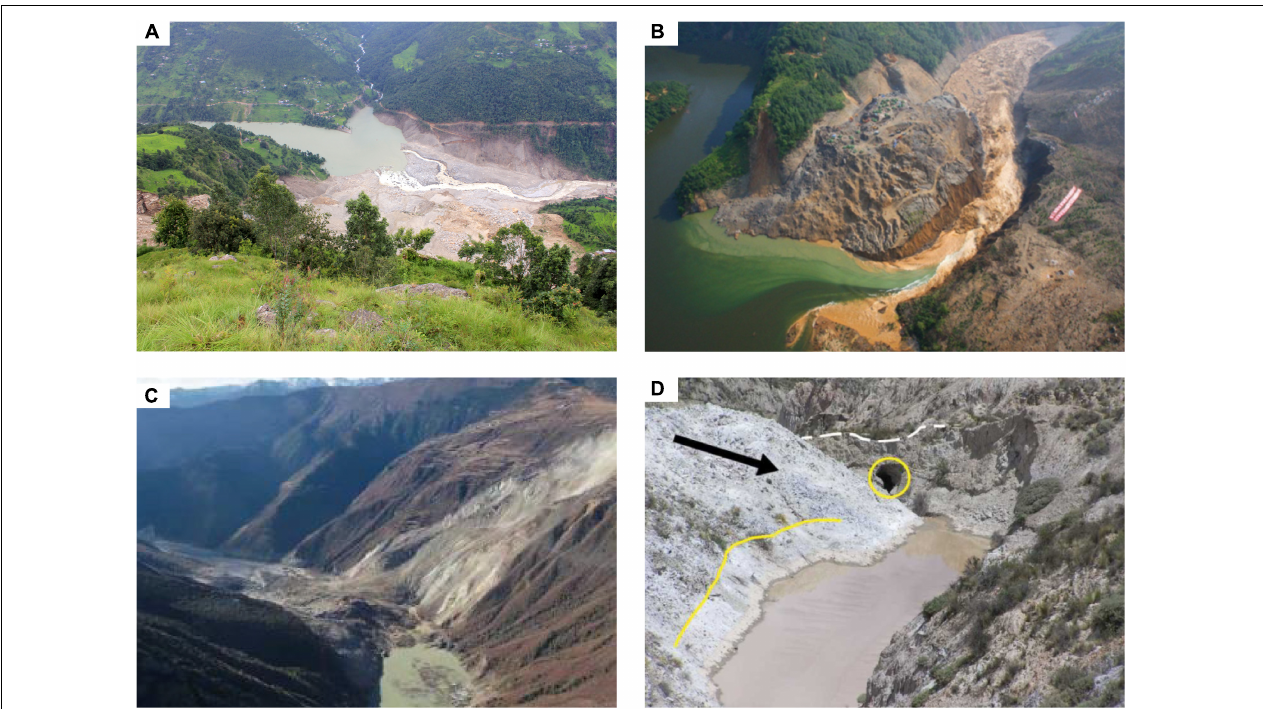
FIGURE 2 | Landslide dam cases. (A) Jure landslide dam induced by rainfall in Nepal on September 18, 2014 (Acharya et al., 2016). It was located at 27 ◦ 46 (cid:48) 1.55 (cid:48)(cid:48) N latitude and 85 ◦ 52 (cid:48) 17.10 (cid:48)(cid:48) E longitude. (B) Tangjiashan landslide dam induced by an earthquake in China on May 12, 2008 (Peng et al., 2014). It was located at 31 ◦ 50 (cid:48) 24 (cid:48)(cid:48) N latitude and 104 ◦ 25 (cid:48) 48 (cid:48)(cid:48) E longitude. (C) Baige landslide dam induced by snowmelt in China on November 3, 2018 (Wang et al., 2020). It was located at 31 ◦ 04 (cid:48) 59 (cid:48)(cid:48) N latitude and 98 ◦ 42 (cid:48) 17 (cid:48)(cid:48) E longitude. (D) Allpacoma landslide dam induced by rainfall in Bolivia on July 18, 2004 (Quenta et al., 2007). Overtopping failure occurred for Jure, Tangjiashan, and Baige landslide dams, whereas seepage failure occurred for Allpacoma landslide dam.